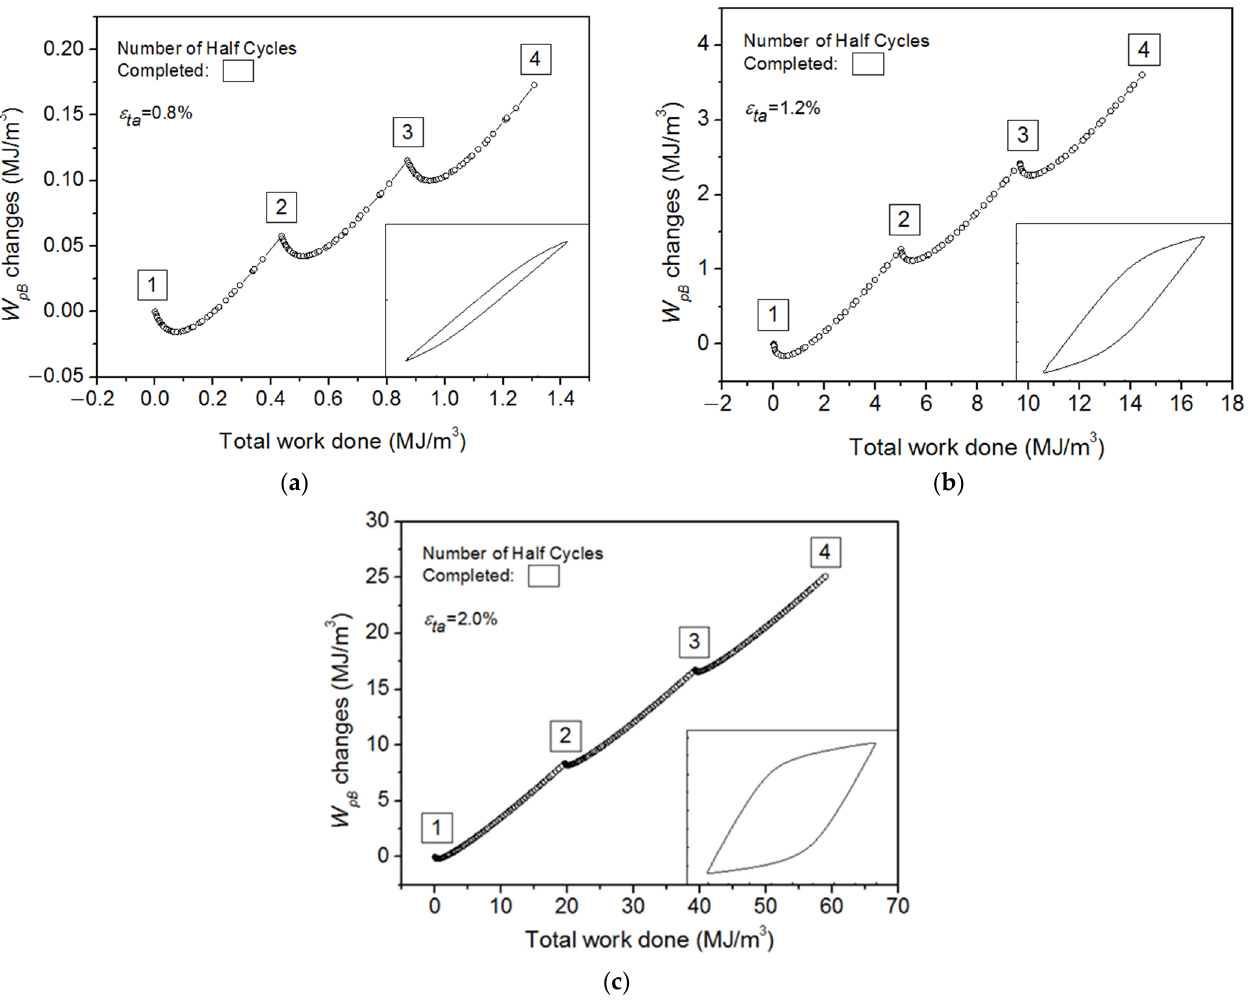
Figure 10. The accumulated plastic work of back stress vs. accumulated plastic strain energy for Ti-6Al-4V: ( a ) ε ta = 0.8%; ( b ) ε ta = 1.2%; and ( c ) ε ta =